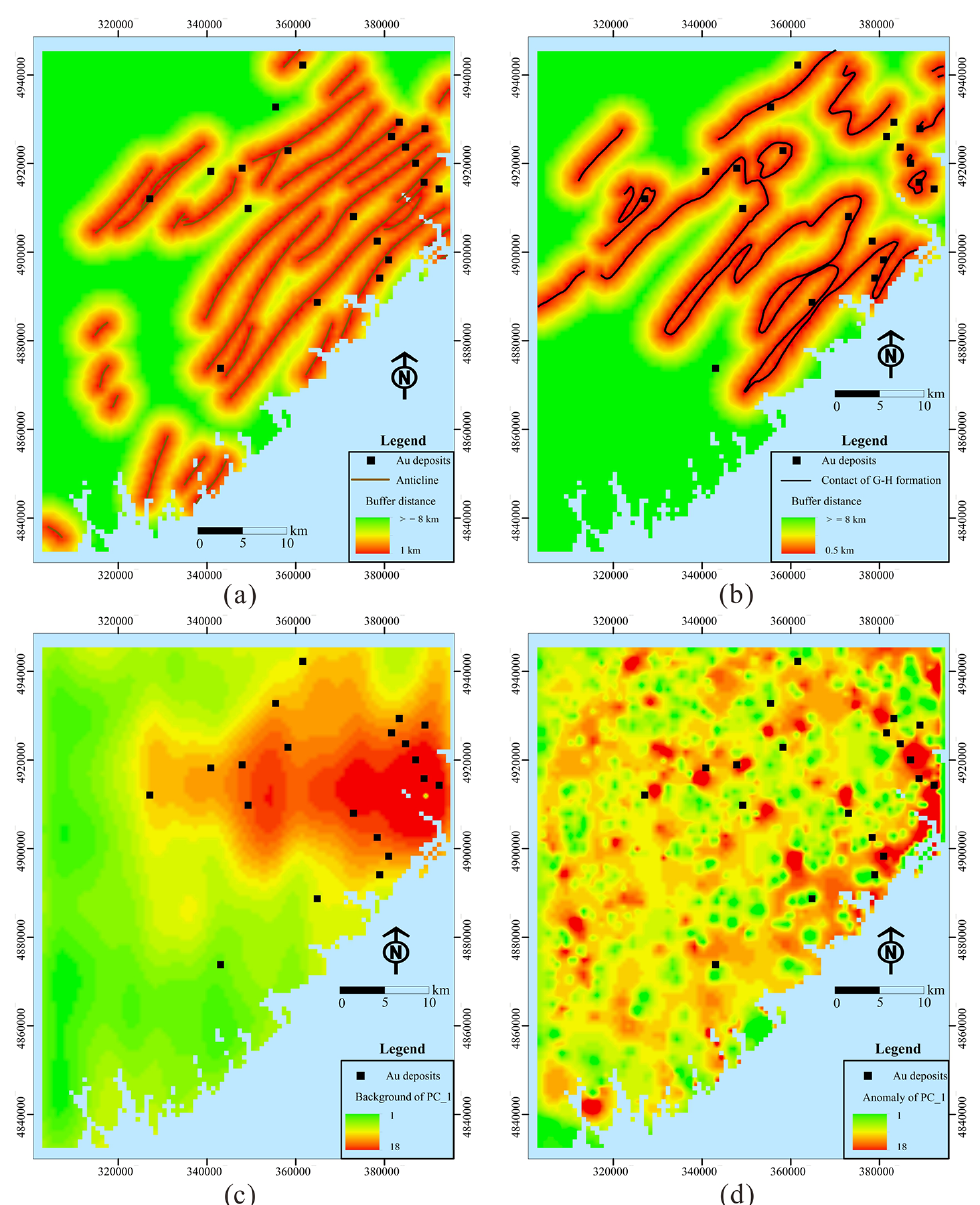
Figure 4. Evidential layers used to map Au deposits in this study: buffer of anticline axes (a) , buffer for the contact of Goldenville–Halifax Formation (b) , and background (c) and anomaly (d) separated with the S-A filtering method based on the ore element loadings of the first